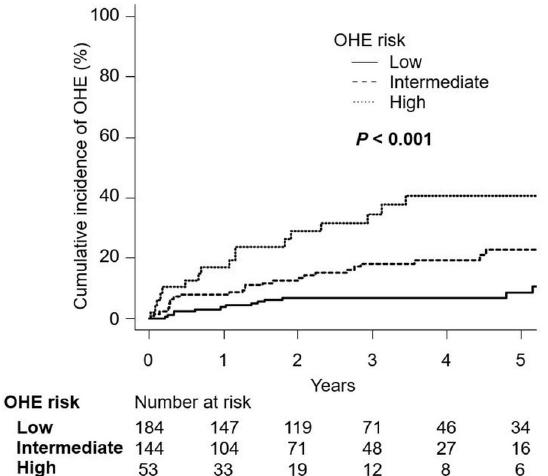
Fig 3. Cumulative incidence of OHE in the OHE low-, intermediate-, and high-risk groups. The cumulative incidence was estimated using the cumulative incidence function and compared between the groups using Gray’s test. Abbreviation: OHE, overt hepatic